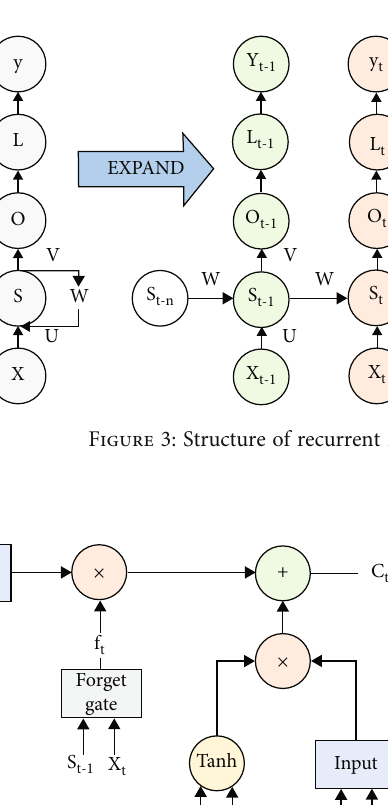
Figure 2: Video big data analysis platform for smart city development.